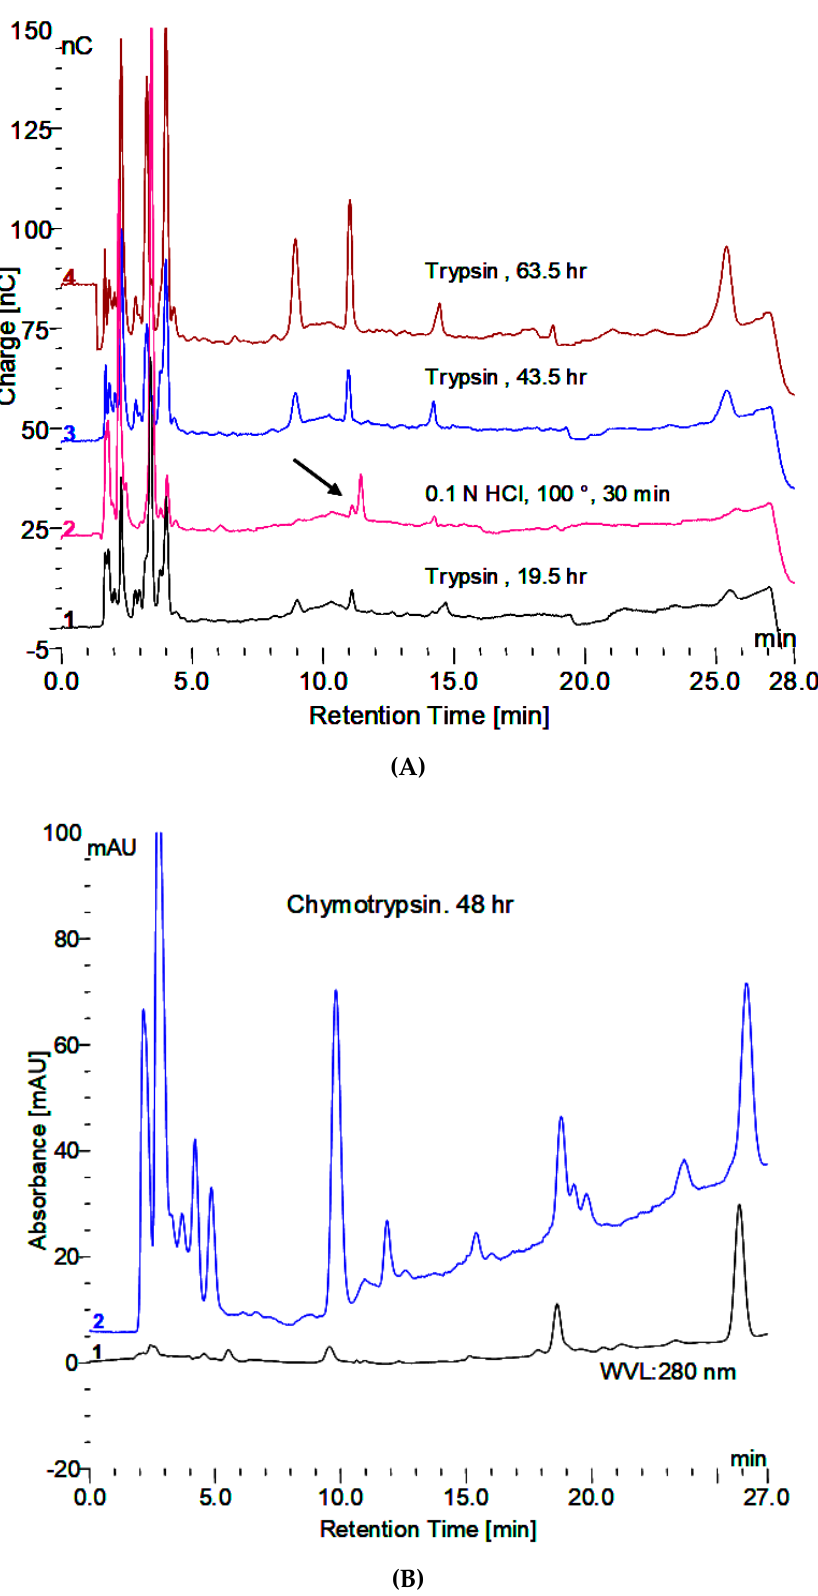
Figure 5. ( A ) Release of peptide bound oligosaccharides by trypsin and 0.1 N HCl. The HCl treatment was at the beginning. The trypsin treatment was for the indicated time at 37 °C under toluene. ( B ) Release of peptide bound oligosaccharides by chymotrypsin showing carbohydrate in blue and protein in black.